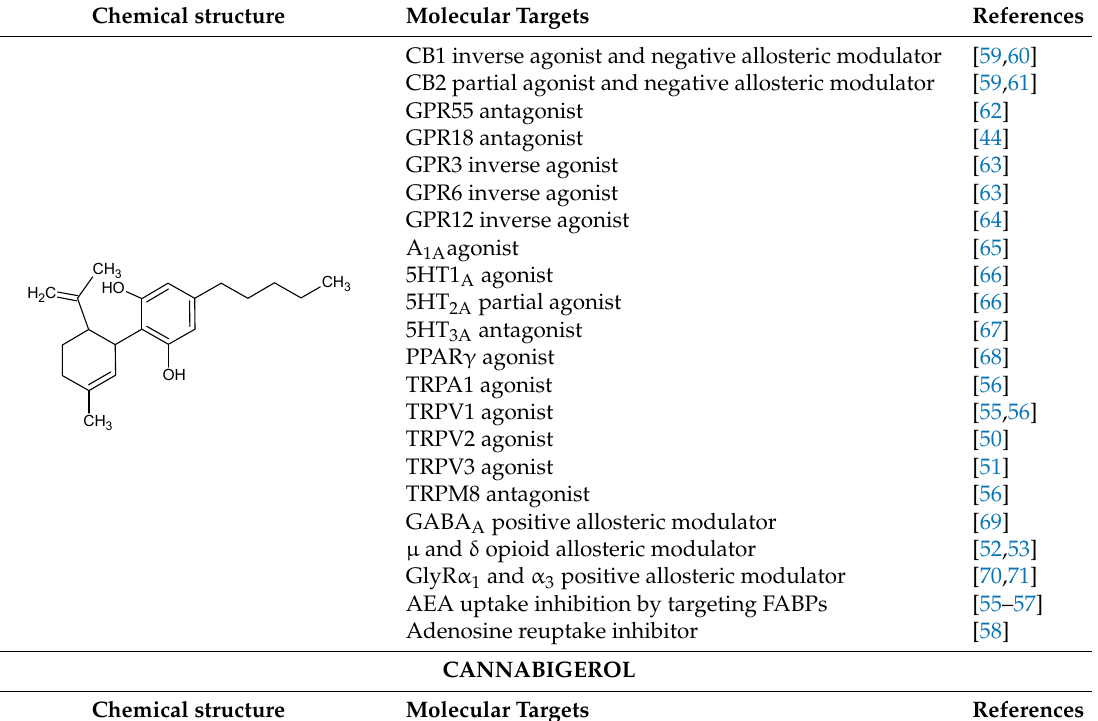
Table 2. Molecular targets of the most abundant phytocannabinoids in Cannabis sativa . Δ 9 -TETRAHYDROCANNABINOL Chemical structure Molecular